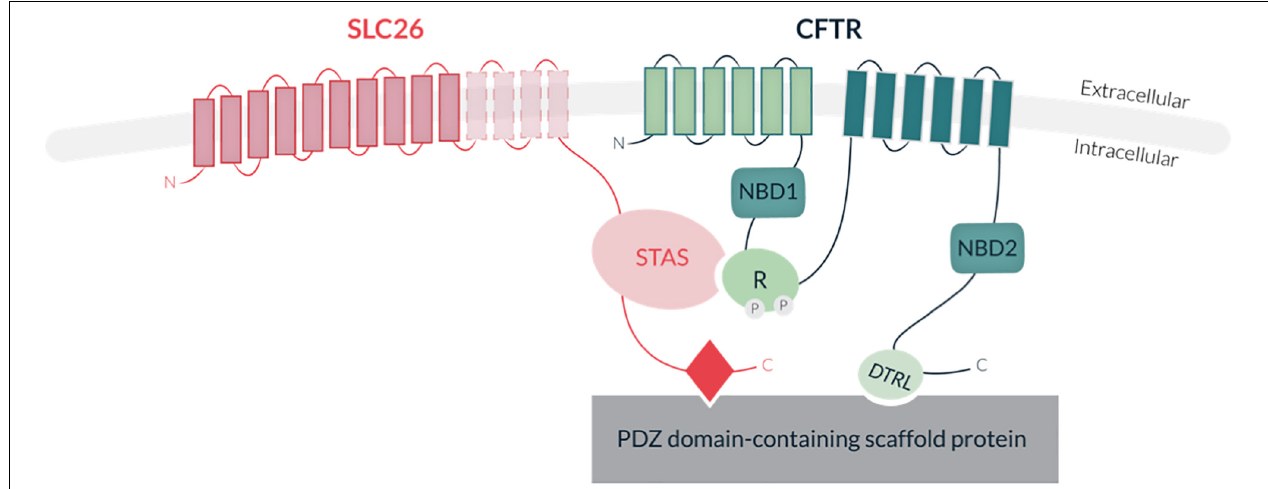
FIGURE 5 | Schematic representation of SLC26 protein structure and interaction with the Cystic Fibrosis Transmembrane conductance Channel (CFTR). SLC26 proteins share a conserved transmembrane region of 10–14 hydrohobic spans, associated with their anion transport activity, and a cytoplasmic STAS domain (Sulfate Transporter and Anti-Sigma factor antagonist), involved in protein-protein interaction and regulation. Some members also contain a PDZ binding motif at their carboxy-terminal extremity. The CFTR protein consists of two transmembrane domains (TMD) (each containing six spans of alpha helices), two nucleotide-binding domains (NBD1 and NBD2) and a central regulatory domain (R-domain). CFTR activity is regulated by PKA-phosphorylation of the R-domain and ATP binding and hydrolysis at the two NBDs. Direct interaction of SLC26 with CFTR is mediated by the STAS domain and the regulatory (R) domain of CFTR. Indirect interaction of the proteins occurs through binding of both SLC26s and CFTR to common PDZ motif-containing scaffold